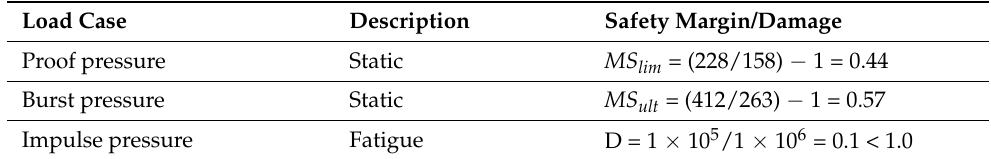
Figure 6. Stress maps (limit pressure load, PP = 31.05 MPa). ( a ) Von Mises stress (outer walls); ( b ) Von Mises stress (inner flow channels); ( c ) Max Principal stress (inner flow channels); ( d ) zoom on Max Principal peak. Table 6. Finite element analysis